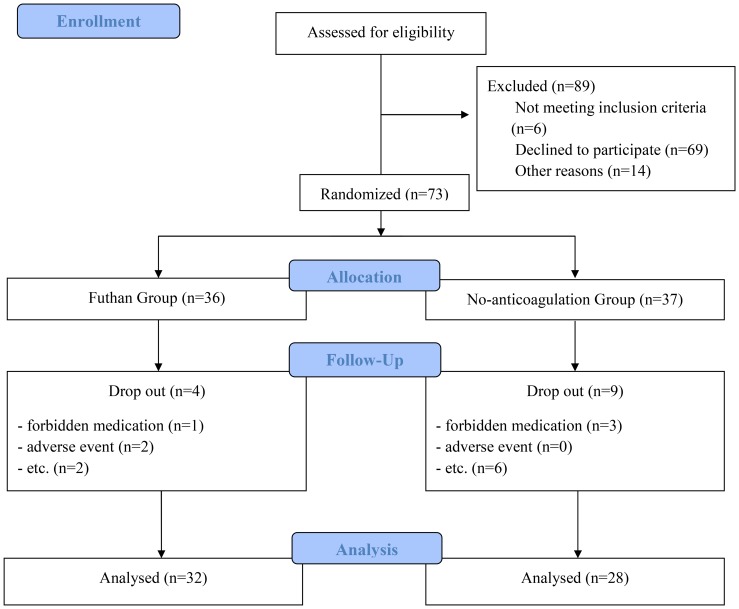
Enrollment, randomization, and follow up.Out of 162 patients who were eligible to the study, 73 patients were enrolled in the study, and 60 patients completed the study for analysis.